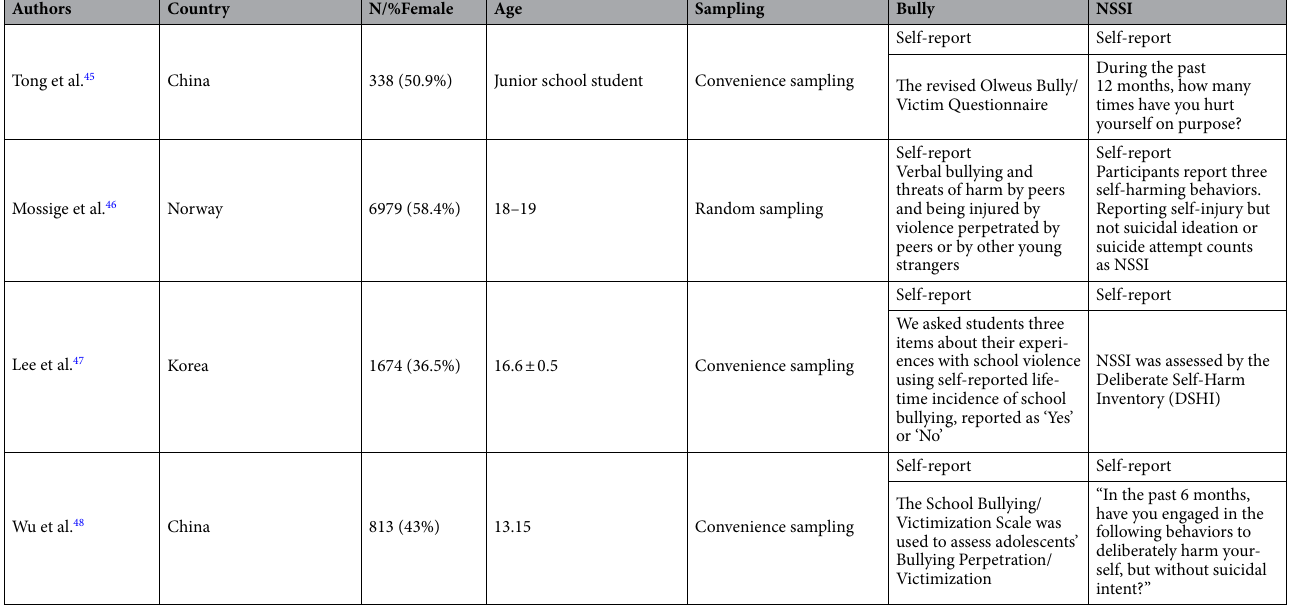
Table 1. Studies included in the meta-analysis.